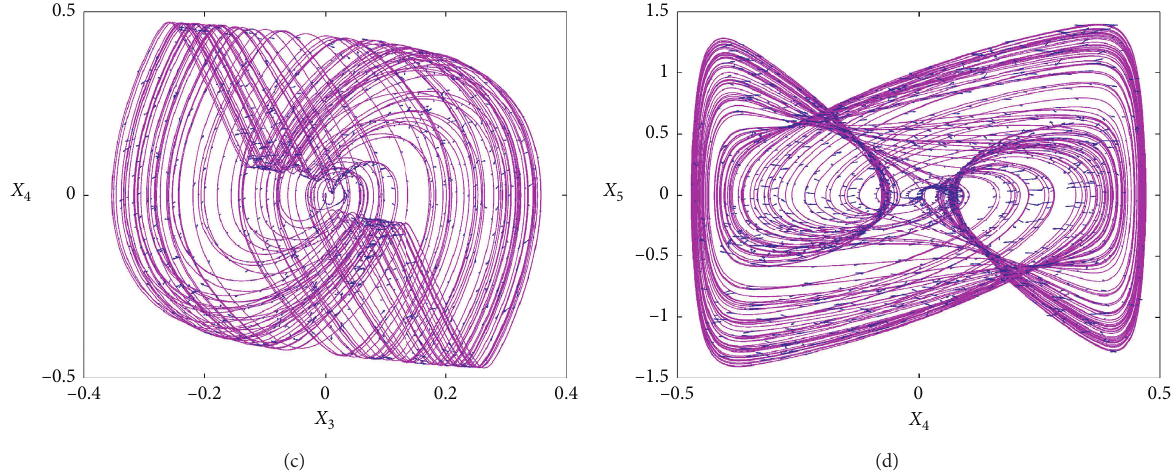
Figure 4: The zero Lyapunov vectors (LE2): (a) first and second components of zero Lyapunov vectors (LE2) in x and third components of zero Lyapunov vectors (LE2) in x − x x plane; (d) fourth and fifth components of zero Lyapunov vectors (LE2) in x 3 4